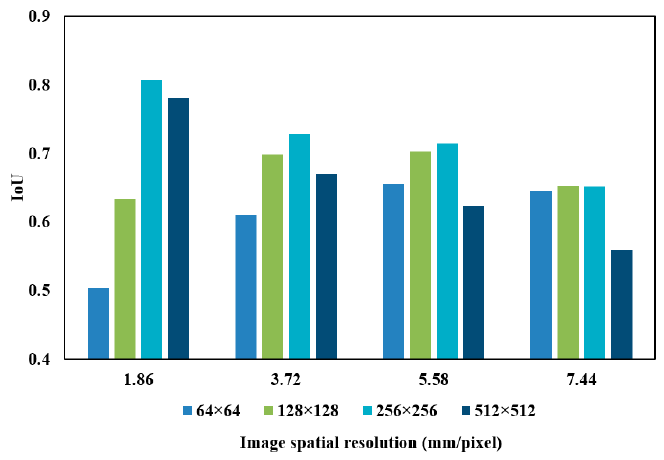
Figure 7. IoU results obtained for four image spatial resolutions and four patch sizes.